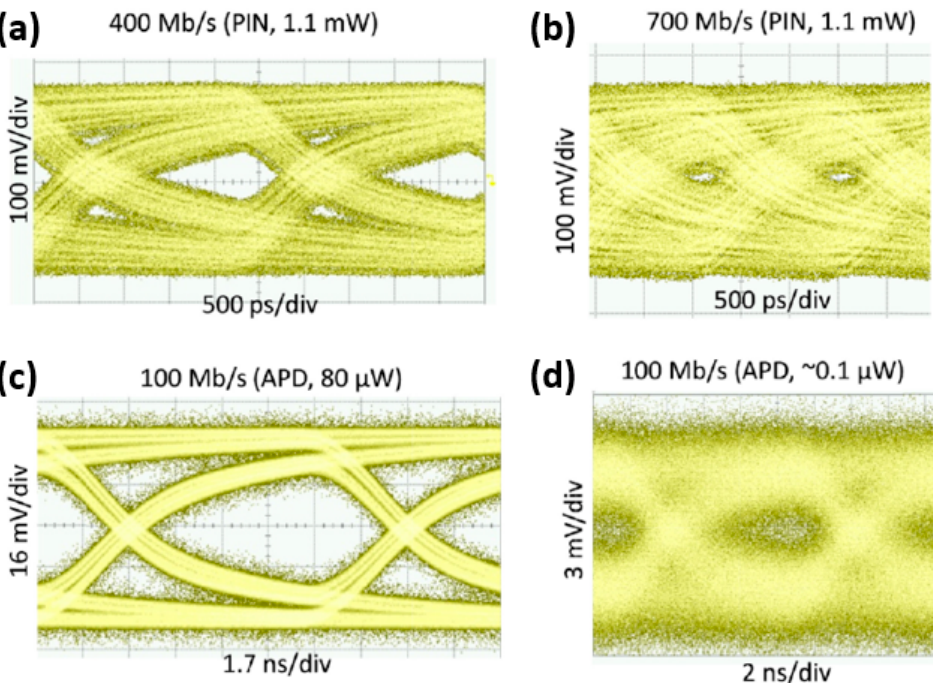
Figure 13. Eye diagrams at data rates of ( a ) 400 Mb / s and ( b ) 700 Mb / s using a p-i-n (PIN) photodetector; eye diagrams with received powers of ( c ) 80 µ W and ( d ) 0.1 µ W at 100 Mb / s using the